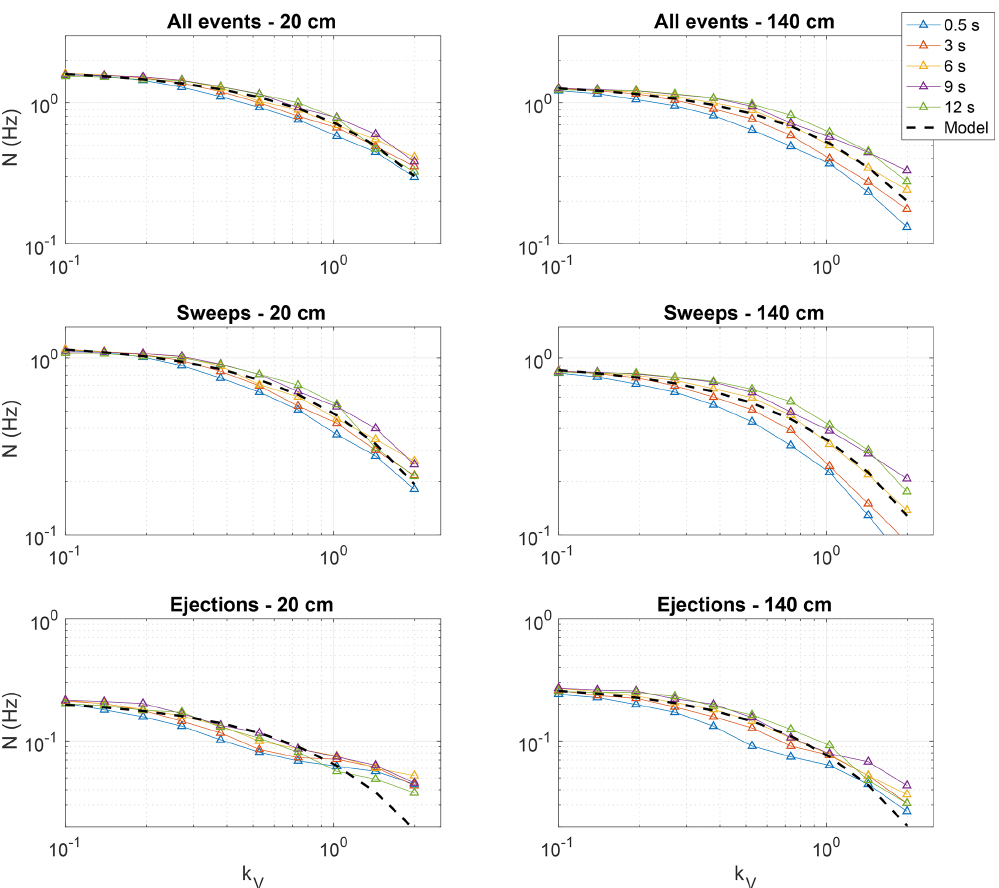
Figure 5. Example of variation in event frequency ( N ) over VITA thresholds ( k V ) for different averaging times (0 . 5 < T < 12s) at k Q = 1 for one 15min study period on 4 December. Least-squares-fitted Eq. (3) curves are overlaid as dashed line for each collection of events: All modified VITA events, sweeps, and ejections as identified at the 20cm (low) or 140cm (high)